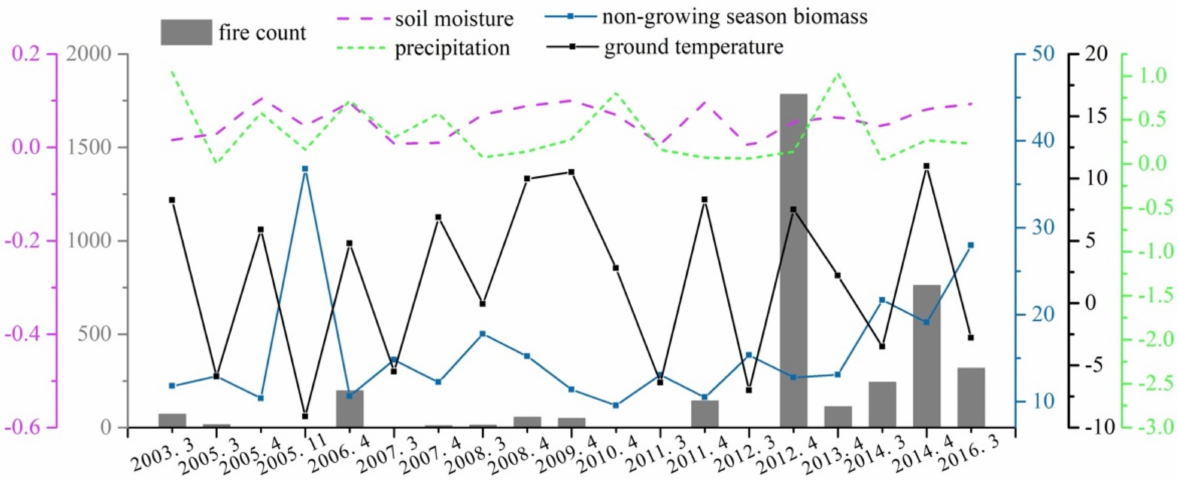
Figure 10. Statistical chart of factors influencing the occurrence of grassland fires during the nongrowing